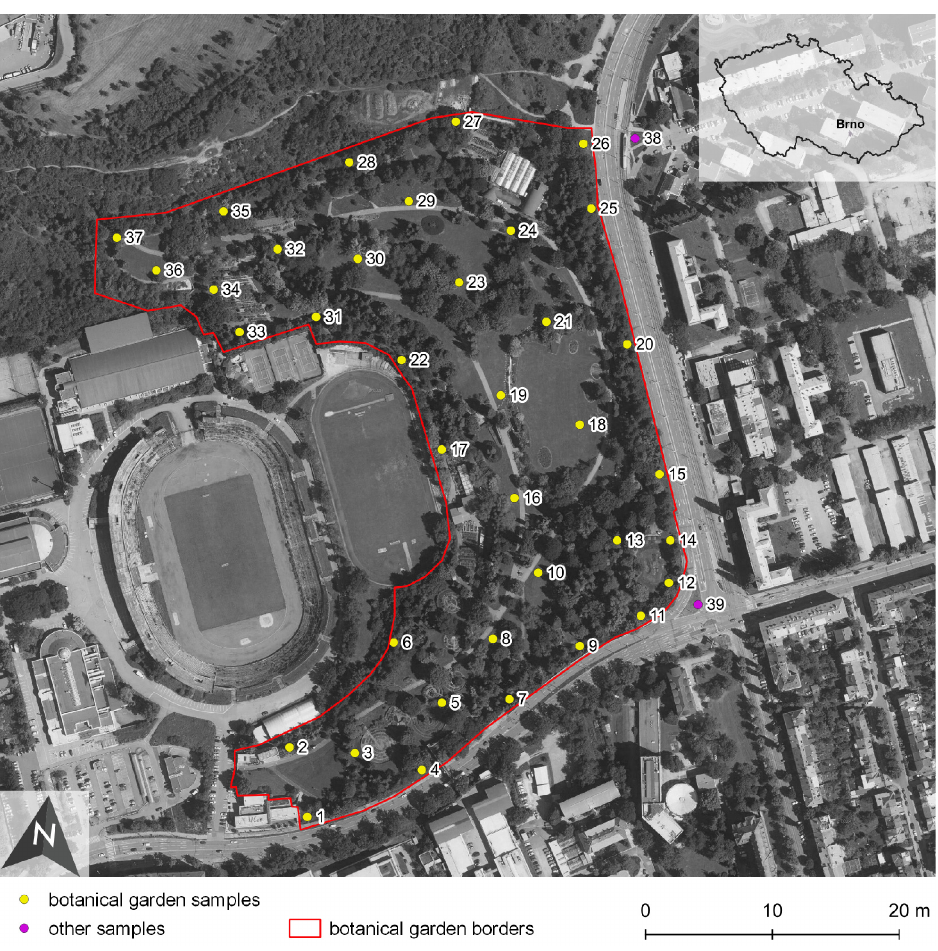
Figure 1. Study site with sampling points in the context of the surrounding urban area.